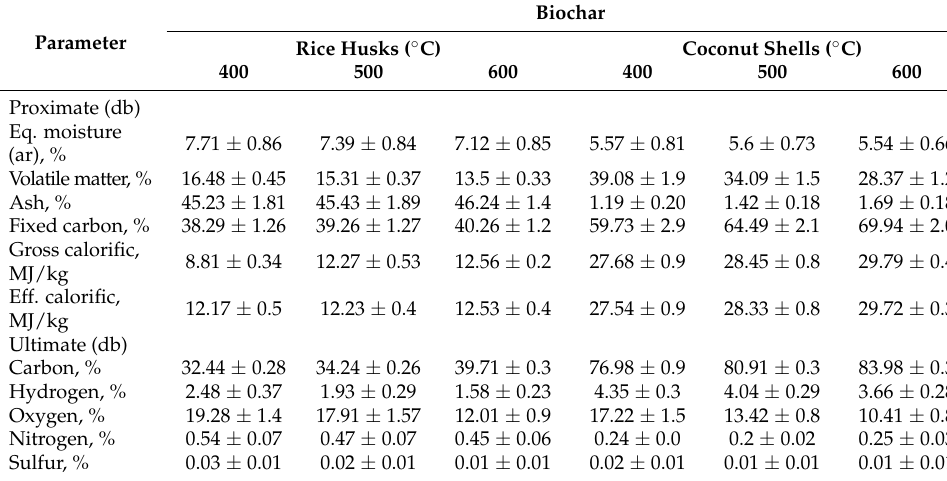
Table 3. Proximate and ultimate analyses of biochar.